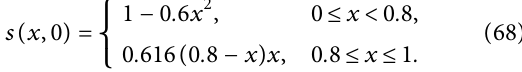
Figure 2 is plotted using the initial condition from